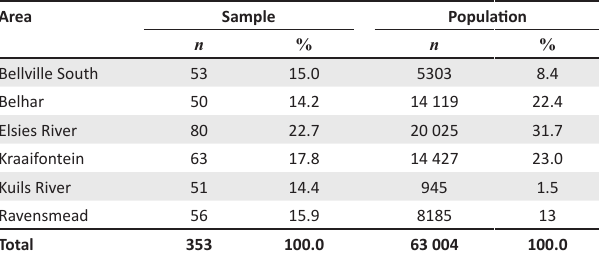
TABLE 1: Residential areas ( N = 353). TABLE 2: House structure classification ( N =